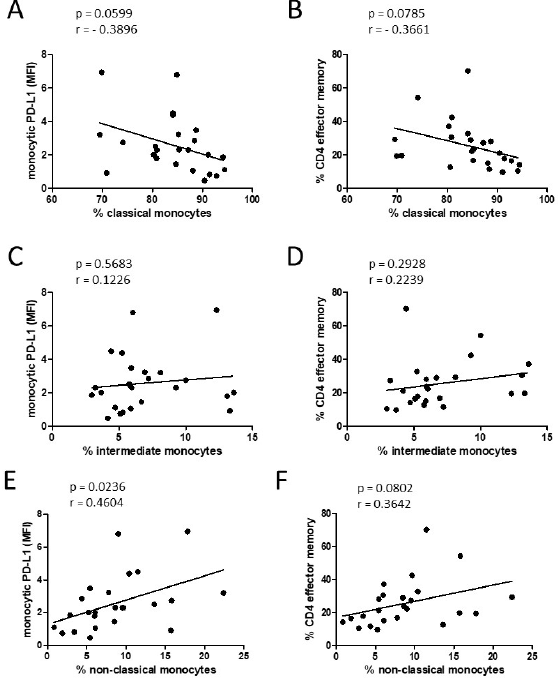
Figure 5. Correlation analysis between different parameters measured in oropharyngeal cancer patients. Abundances of classical monocytes ( A , B ), intermediate monocytes ( C , D ), and nonclassical monocytes ( E , F ) correlated with mean fluorescence intensities (MFIs) of monocytic PD-L1 and percentages of CD4 effector memory T cells. A multivariate progression with the Pearson correlation was performed. The correlation coefficient (r) and p values are given for each pair. p < 0.05 was considered significant. Two different CD16 + monocyte subsets, intermediate and nonclassical, can emerge from the classical monocyte population and were therefore considered individually. In- creased percentages of non-classical-monocytes, but not intermediate monocytes, signifi- cantly correlated with the levels of monocytic PD-L1 expression and correlated by ten- dency with the percentage of CD4 + effector memory T cells (Figure 5).